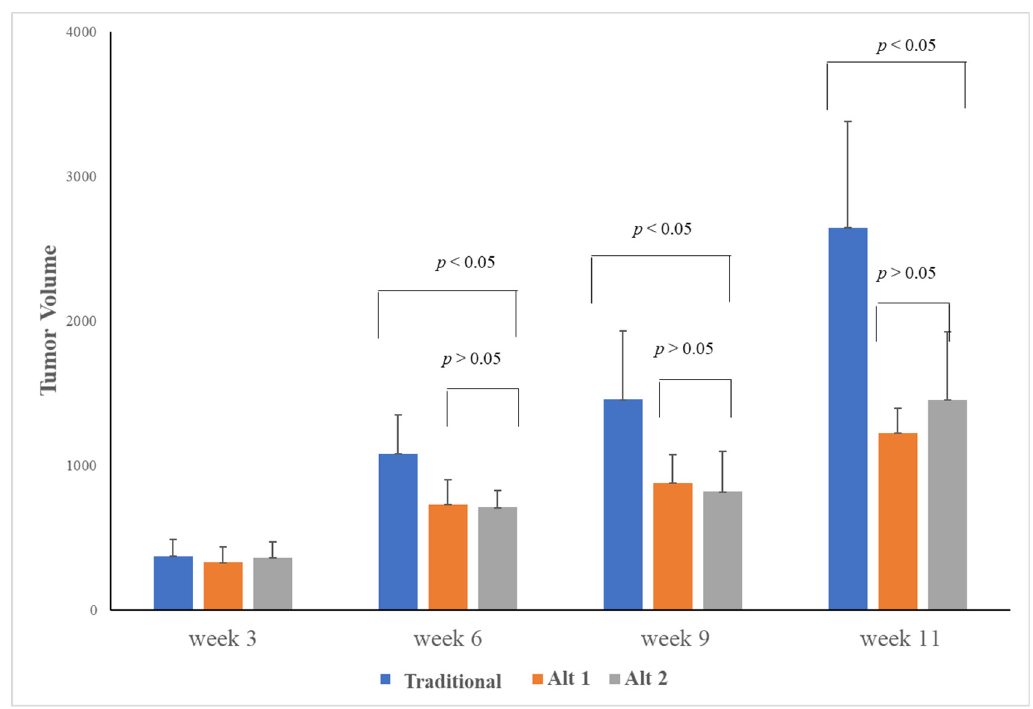
Figure 2. Bar graph showing tumor volumes at different time points.